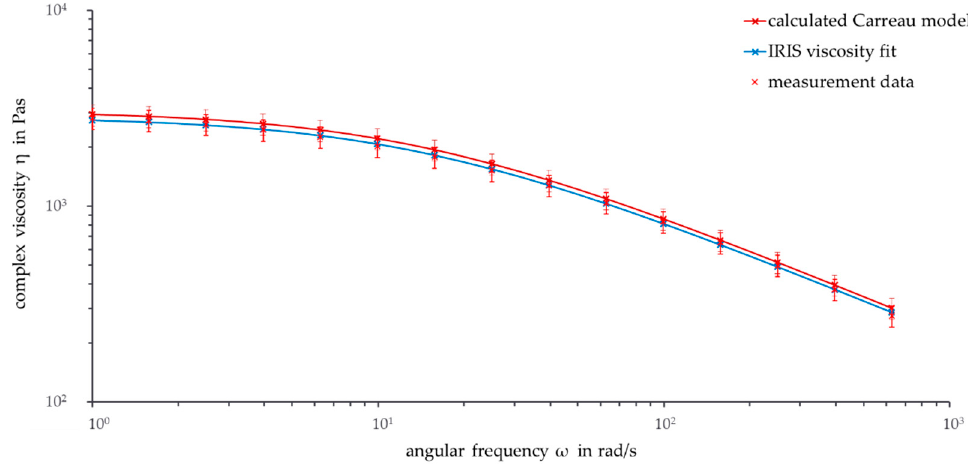
Figure 5. Frequency sweep: Calculated Carreau model, IRIS viscosity fit, and measurement data ( ϑ = 178 °C, ω = 1–628 rad/s).